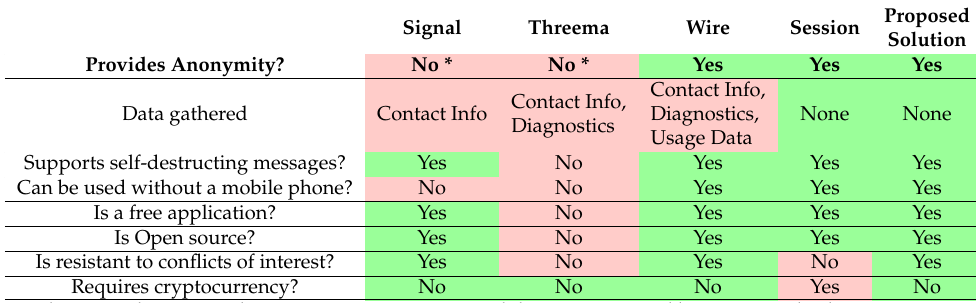
Proposed Solution